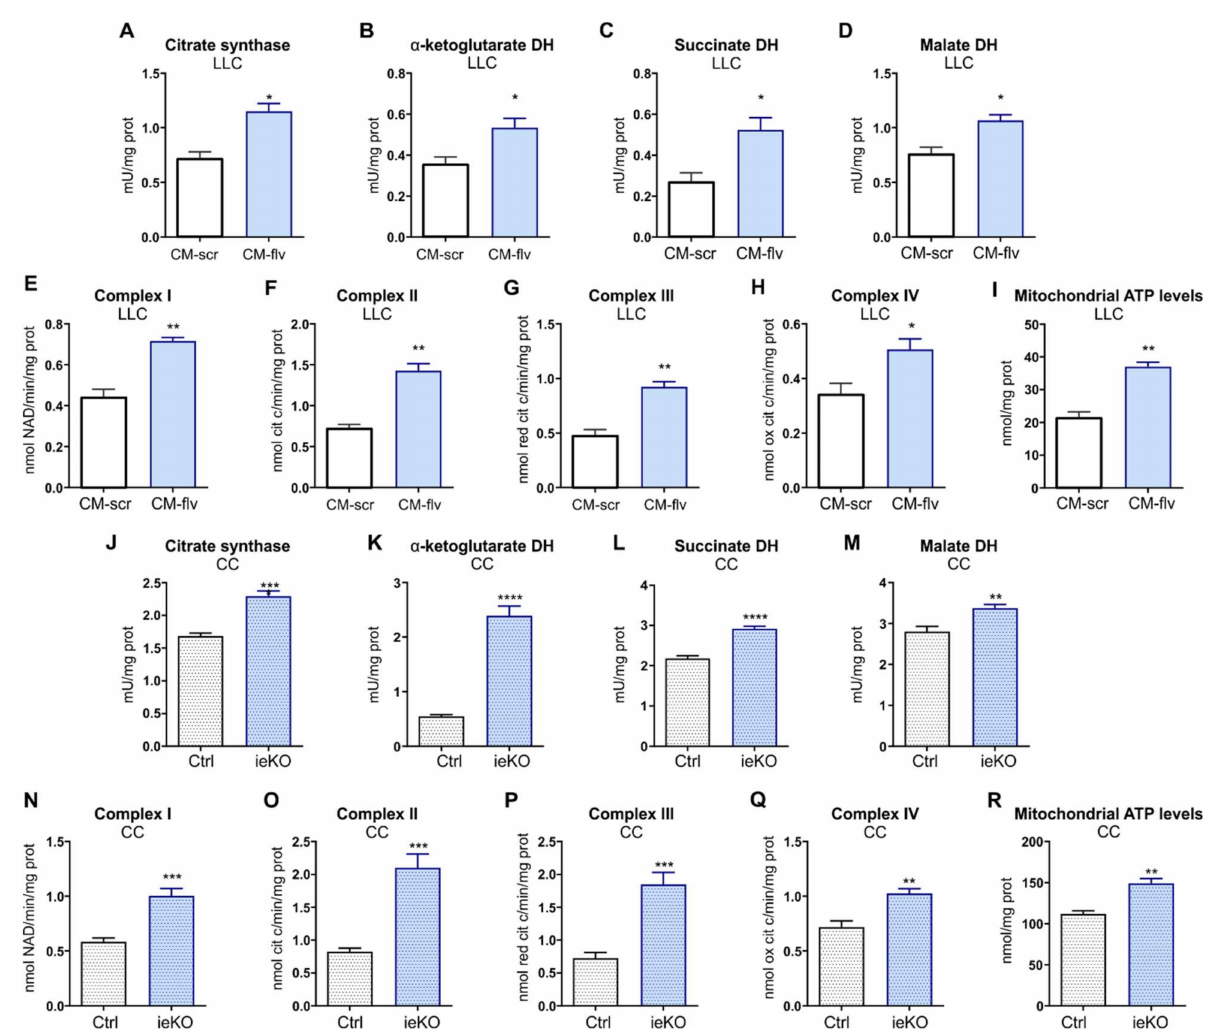
Figure 4. FLVCR1a deficiency in TECs induces a metabolic rewiring in cancer cells (CCs). ( A – H ) Activities of TCA cycle enzymes citrate synthase, α -ketoglutarate dehydrogenase (DH), succinate DH and malate DH, and the mitochondrial electron transport chain (ETC) complexes I–IV in LLC cells treated for 24 h with FLVCR1a -silenced (CM-flv) or control (CM- scr) BTECs-derived CM. Results are expressed as mU/mg mitochondrial proteins for TCA enzymes, nmol NAD+/min/mg of mitochondrial protein for complex I, nmol reduced cytochrome c/min/mg of mitochondrial protein for complexes II–III, and nmol oxidized cytochrome c/min/mg of mitochondrial protein for complex IV. Data represent means ± SEM, n = 3 wells. For statistical analyses, an unpaired Student’s t -test was used. * p < 0.05, ** p < 0.01. ( I ) Mitochondrial ATP levels were measured with a bioluminescent assay kit in LLC cells treated for 24 h with FLVCR1a -silenced (CM-flv) or control (CM-scr) BTECs-derived CM. Results are expressed as nmol/mg of mitochondrial proteins. Data represent means ± SEM, n = 3 wells. For statistical analyses, an unpaired Student’s t -test was used. ** p < 0.01. ( J – Q ) Activities of TCA cycle enzymes citrate synthase, α -ketoglutarate DH, succinate DH and malate DH, and mitochondrial ETC complexes I–IV in CCs isolated by LLC-xenografts developed in Flvcr1a iEC-KO (ieKO) and control (Ctrl) mice. Data are expressed as mU/mg mitochondrial proteins for TCA enzymes, nmol NAD+/min/mg of mitochondrial protein for complex I, nmol reduced cytochrome c/min/mg of mitochondrial protein for complexes II–III, and nmol oxidized cytochrome c/min/mg of mitochondrial protein for complex IV. Data represent means ± SEM, n = 5. For statistical analyses, an unpaired Student’s t -test was used. ** p < 0.01, *** p < 0.001. **** p < 0.0001. ( R ) Mitochondrial ATP levels were measured with a bioluminescent assay kit in CCs isolated by LLC-xenografts developed in Flvcr1a iEC-KO (ieKO) and control (Ctrl) mice. Results are expressed as nmol/mg of mitochondrial proteins. Data represent means ± SEM, n = 5. For statistical analyses, an unpaired Student’s t -test was used. ** p <